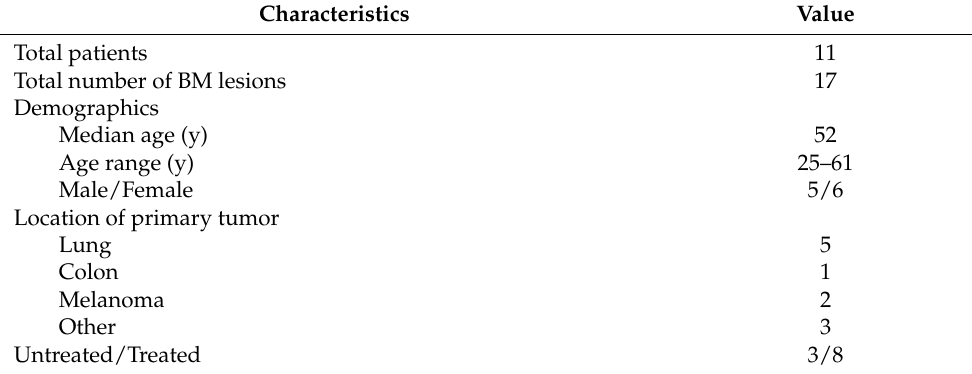
Table 1. Patient